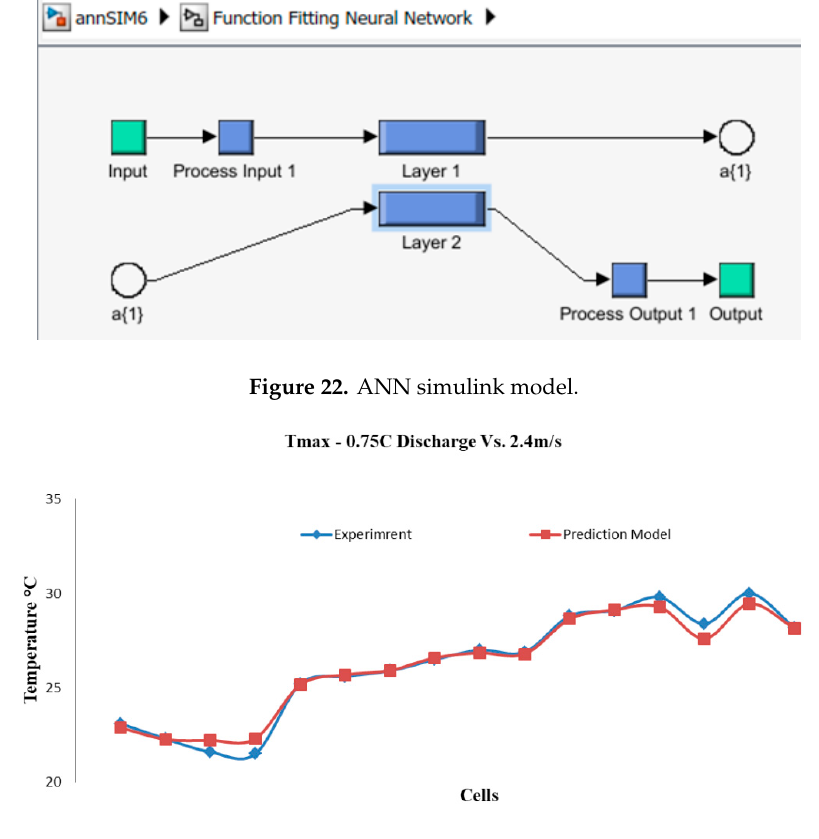
Figure 23. Predicted maximum cell temperature (Tmax) versus actual value.